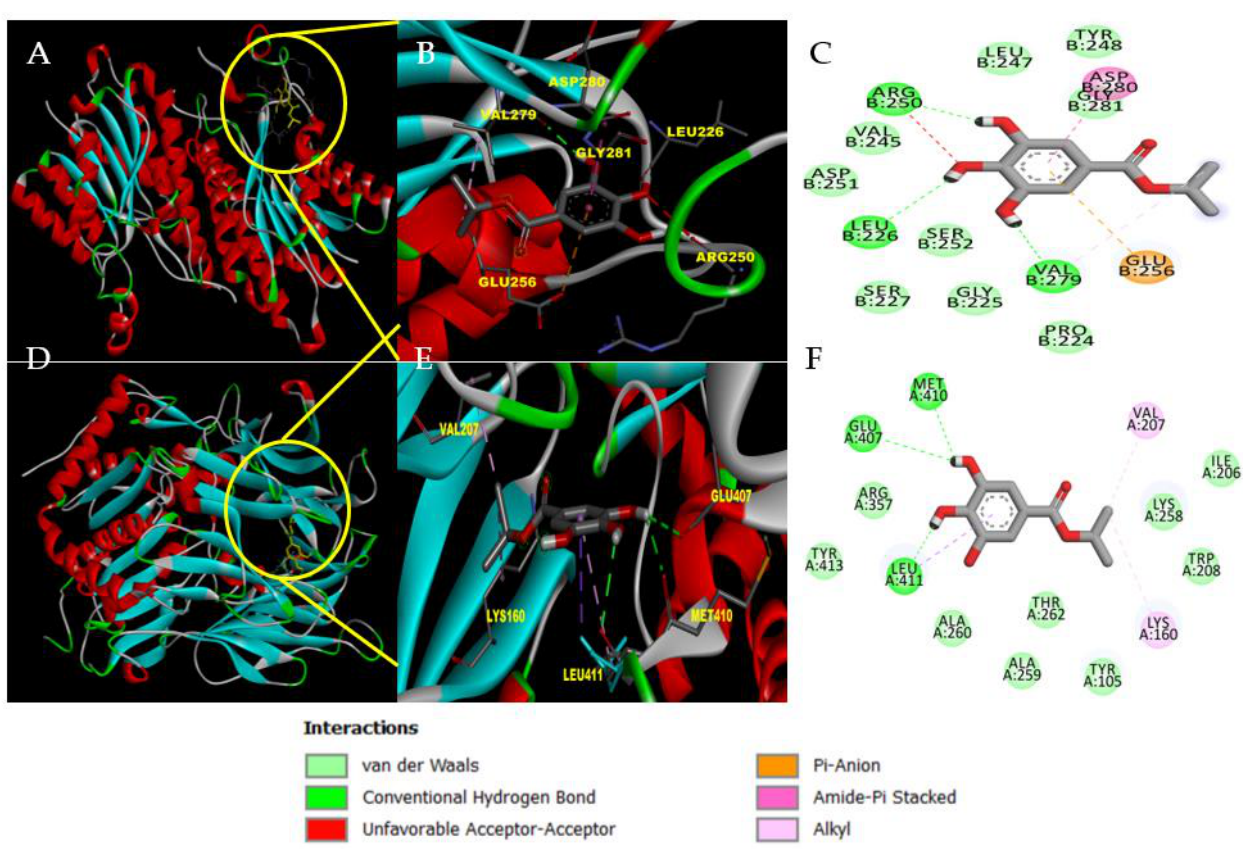
Figure 3. Molecular docking of the most favorable interaction of IPG with the active site of PTR1 and the active site of OPB. ( A ) Active site of pteridine reductase — PTR1; ( B ) 3D interaction of IPG with PTR1; ( C ) 2D interaction of IPG with PTR1; ( D ) Active site of oligopeptidase B — OPB; ( E ) 3D interaction of IPG with OPB; ( F ) 2D interaction of IPG with OPB.